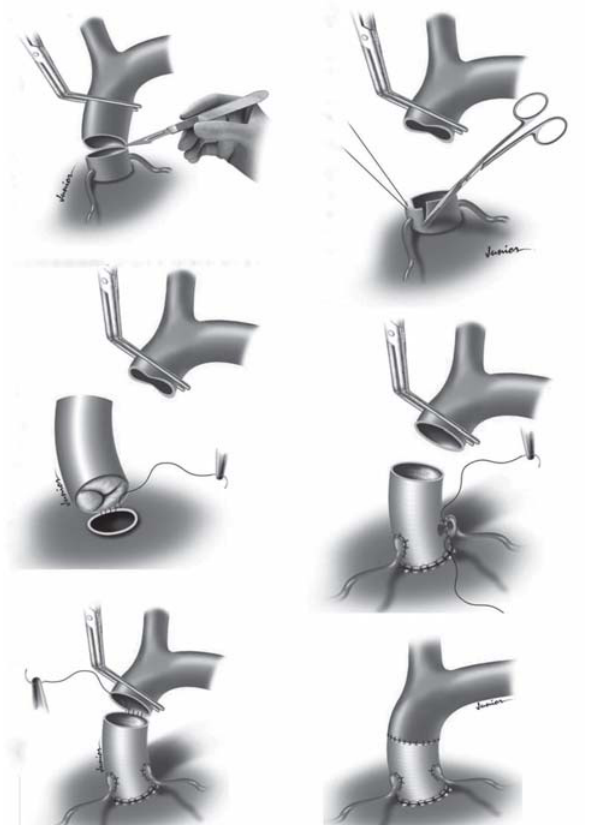
Fig. 1 - Sequência completa da troca da aorta ascendente e valva aórtica pelo CVAP